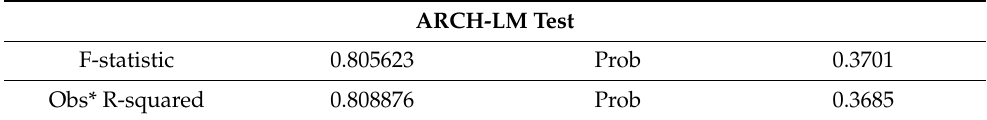
Table 5. Obtained results for checking heteroscedasticity of